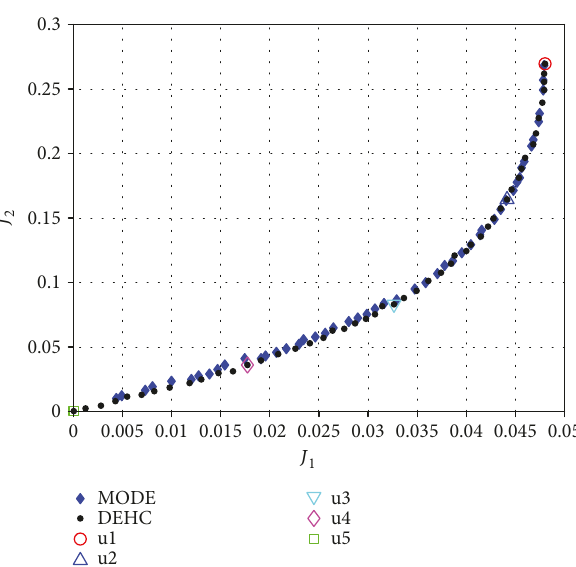
Figure 11: Mean IS on DTLZ2 as the number of objectives increases.